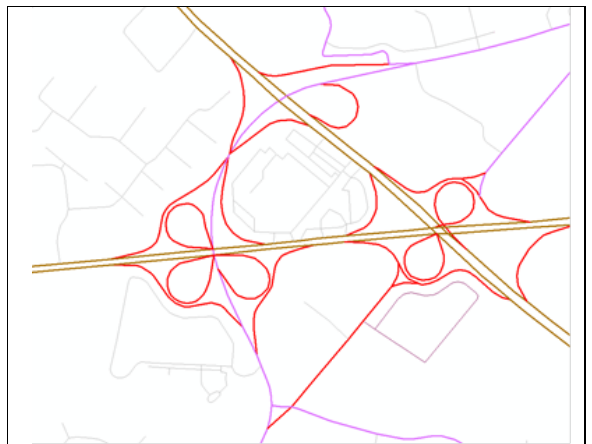
Figure 13. Knowledge discovery through spatial reasoning Data source: HERE In Figure 13, one type of data errors is: missing intersections of some ramps with highways. Because of this error, the expected searched and analyzed. In the presence of divided highways among the neighbors, the ramp-highway relation will be determined as if an intersection